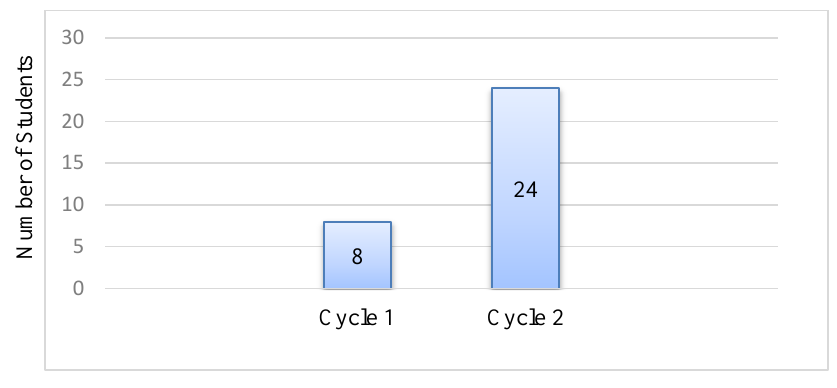
Figure 2: Students’ Score Improvement in the